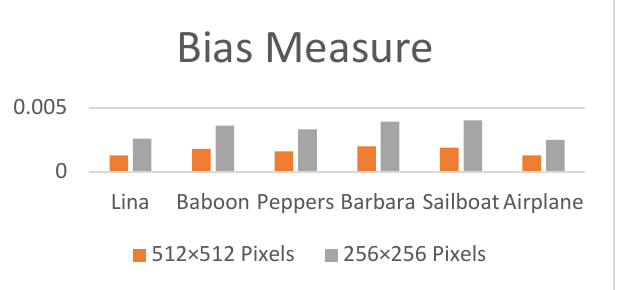
Figure 8. Bias measure for embedding 2000 bytes in colour images of sizes 512 × 512 and 256 × 256.